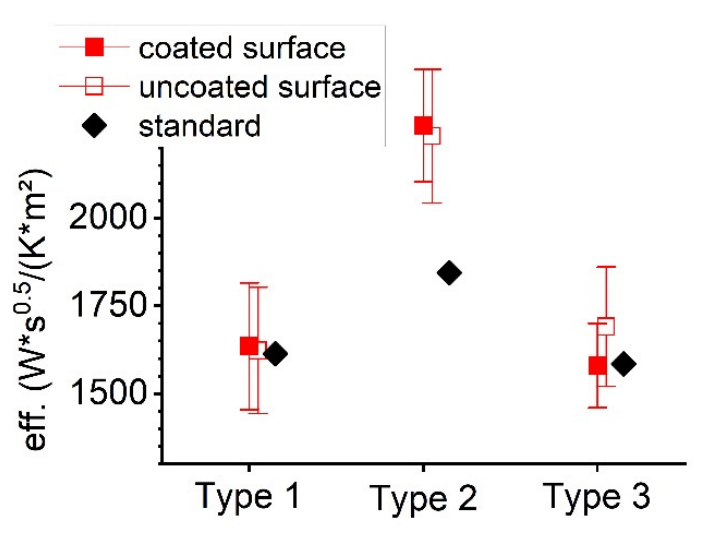
Figure 12. Overview about the effusivities of the three investigated concrete samples with their uncertainties and the value required by the standard [23].